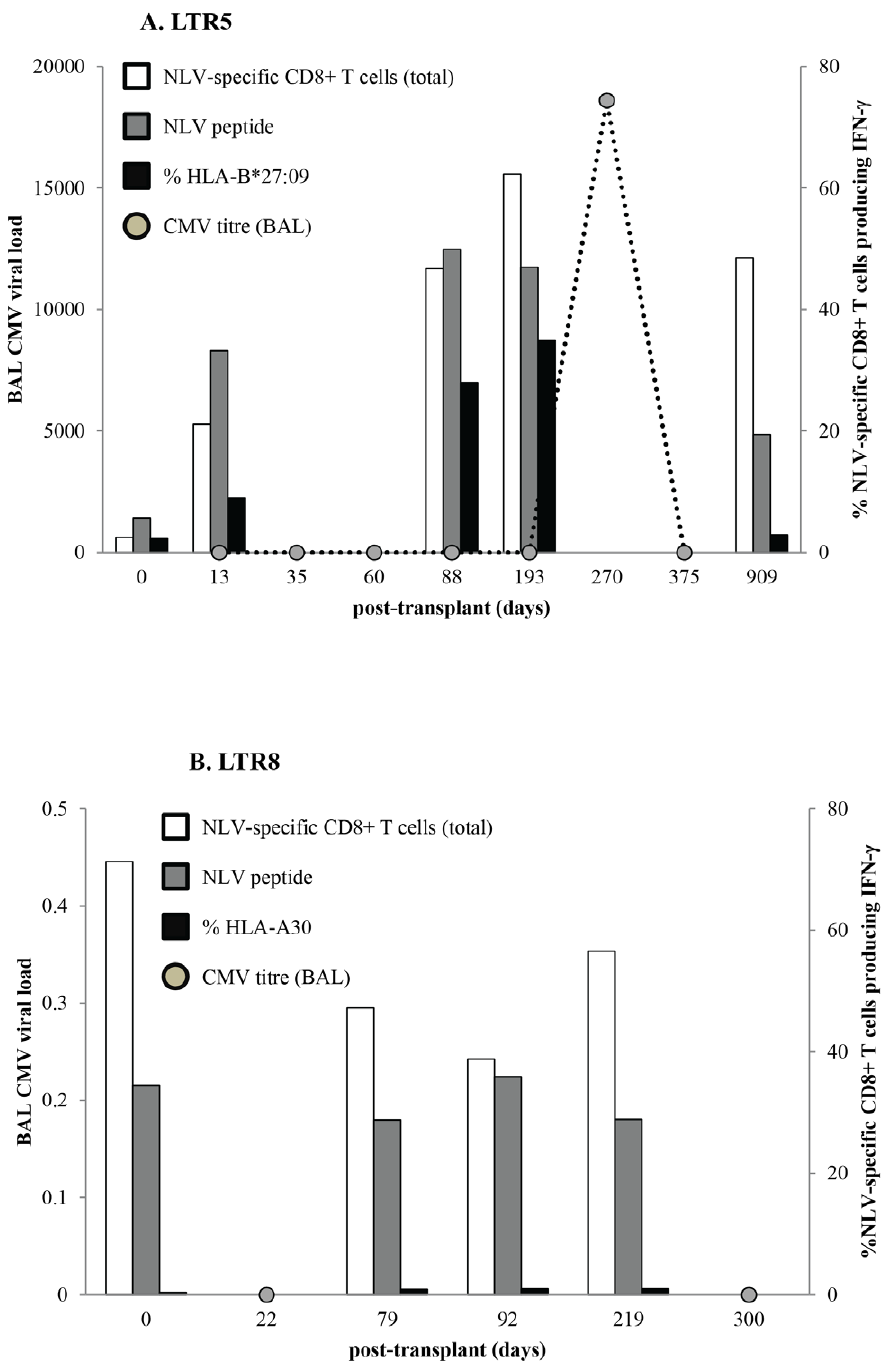
Figure 6. Presence of CMV reactivation increases magnitude of cross-reactivity against the allograft. Comparison of CMV viral load in the BAL (grey circles, left y-axis) and NLV-specific cross-reactivity responses towards B27 and A30 (6 hour ICS assay using day 13 T cells) were measured against time after lung transplant in LTR5 (top) and LTR8 (bottom), respectively. A CMV reactivation episode was classified for viral titres above 10,000. LTR5 experienced CMV reactivation at day 270 post-transplant but had ceased after day 375. A steady increase in B*27:09-cross- reactivity response based on %IFN- c production of tetramer + CD8 + gated cells (black bars, right y-axis) and %tetramer + CD8 + cells of total CD8 + T cells (white bars, right y-axis) were observed prior to CMV reactivation event at day 193 but had dropped to pre-transplant levels after CMV reactivation had ceased. For LTR8, BAL CMV viral titre was not detected post-transplant. In alignment, A30 cross-reactivity and %tetramer + CD8 + cells of total CD8 + T cells remained consistent post-transplant.